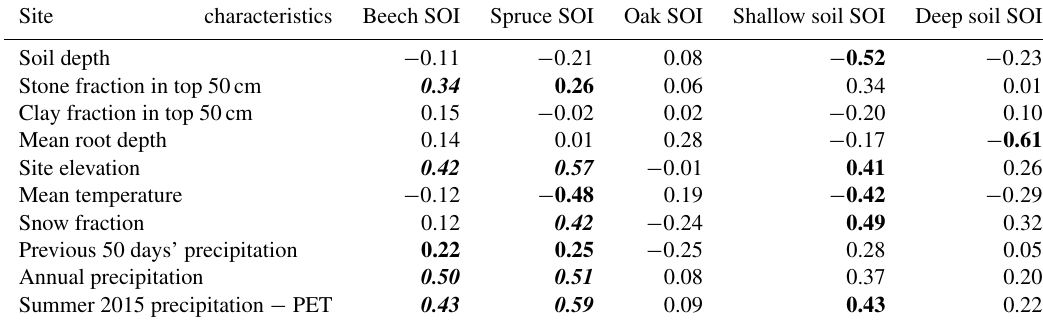
Table 1. Spearman (rank) correlations between site characteristics and xylem water and lysimeter soil water SOI, where statistically sig- nificant correlations are indicated with bold fonts ( p< 0 . 05) and bold italic fonts ( p< 0 . 01); see Table S1 for a more extensive correlation table. Site characteristics Beech SOI Spruce SOI Oak SOI Shallow soil SOI Soil depth Stone fraction in top